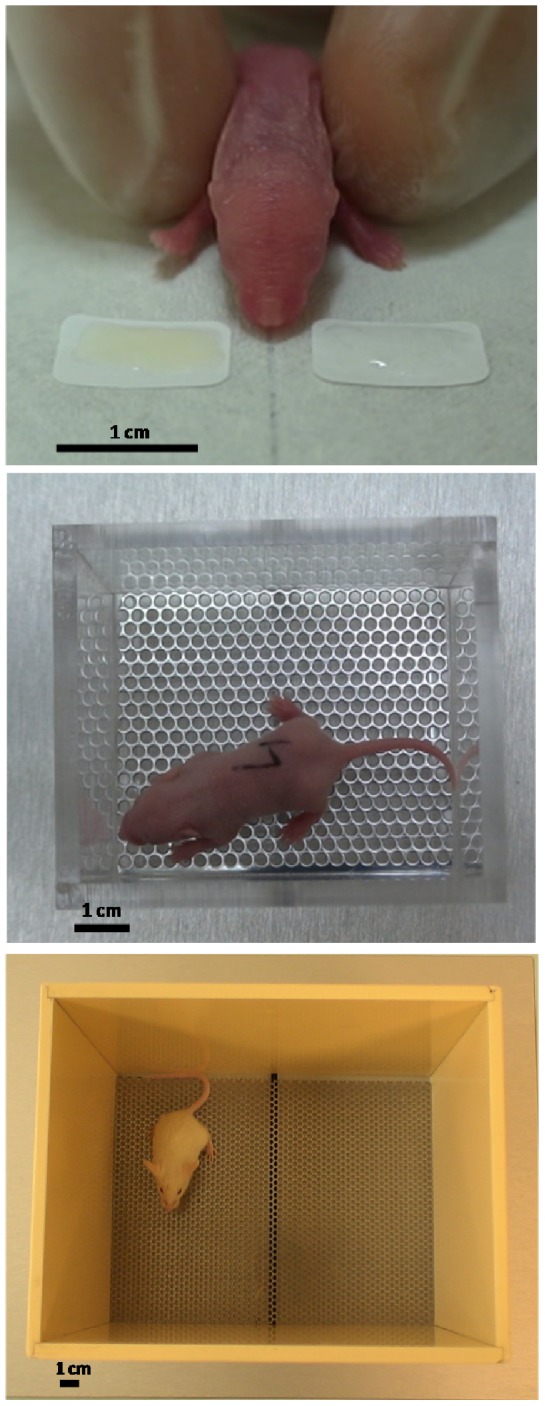
Absolute attraction to milk odors from different lactational stages against the control stimulus.Box plot of the duration 2, 6, and 15 day-old (P2, P6 and P15) mouse pups spent oriented to: 1) milk of lactation day 2 (L2) vs. water (W), 2) milk of lactation day 6 (L6) vs. water, and 3) milk of lactation day 15 (L15) vs. water. The dashed line indicates the theoretical level of random orientation. Wilcoxon's tests: ** p<0.01, * p<0.05. The central square within the box represents the median; the box encloses the interquartile range; whiskers show 1.5 times the interquartile range, “o” indicate outliers.